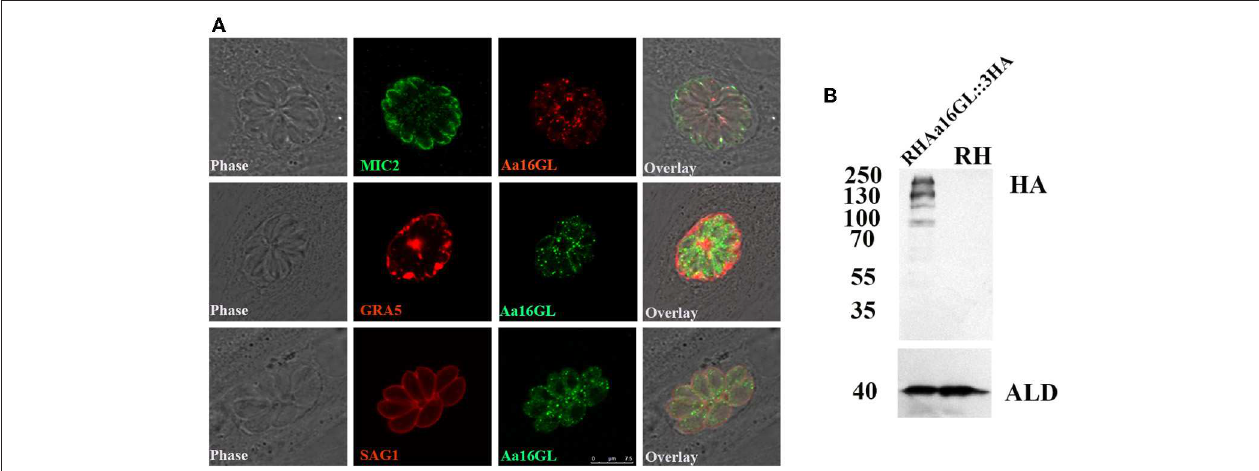
FIGURE 1 | Tagging and localization of amylo-alpha-1,6-glucosidase (Aa16GL). (A) Localization of Aa16GL in the cytoplasm with several small puncta by immunofluorescence analysis. (B) Western blotting confirmed that 3 × HA tag was successfully inserted into the C-terminal of Aa16GL. The 3 × HA-tagged Aa16GL is about 208 KDa (the highest band), and the other bands may be due to the presence of cleavage or degradation. Anti-aldolase (ALD) served as a loading control.